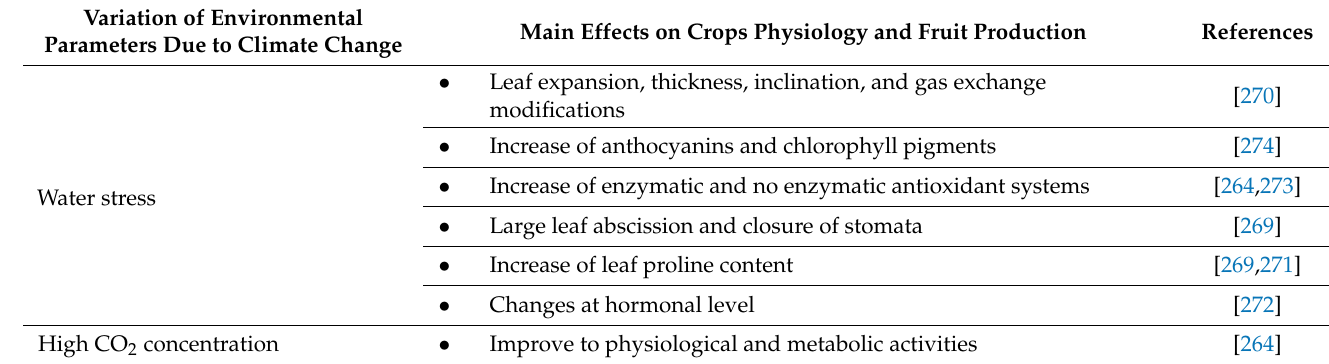
Table 5. Summary of principal effects of environmental conditions variation on fig species.